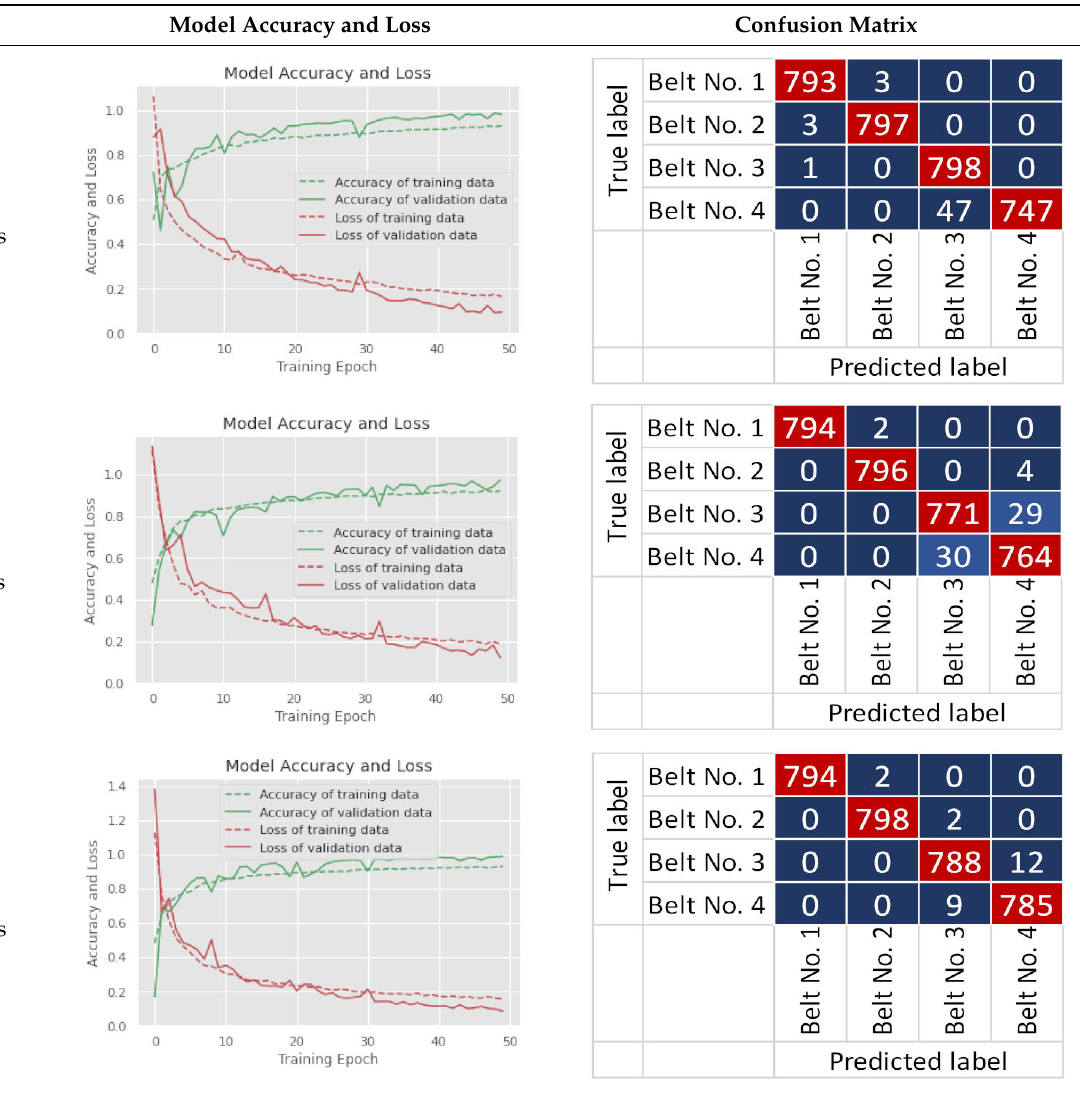
Table 5. Model accuracy and loss and confusion matrix of single-axis force